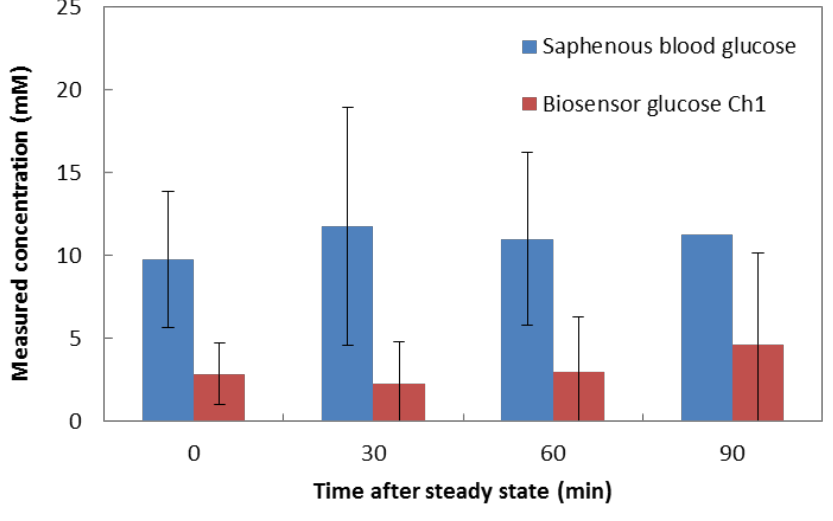
Figure 9. Average whole blood and intramuscular (biosensor, 650 mV) glucose response at 30 min intervals after reaching steady state in the trapezius muscle of MDEA-1 in a male Sprague-Dawley rat of 412 g, MDEA-2 in a male Sprague-Dawley rat of 408 g and MDEA-3 in a female Sprague-Dawley rat of 265 g (infusions were of 3 M glucose in PBS, error bars show standard deviation of n ≥ 2).